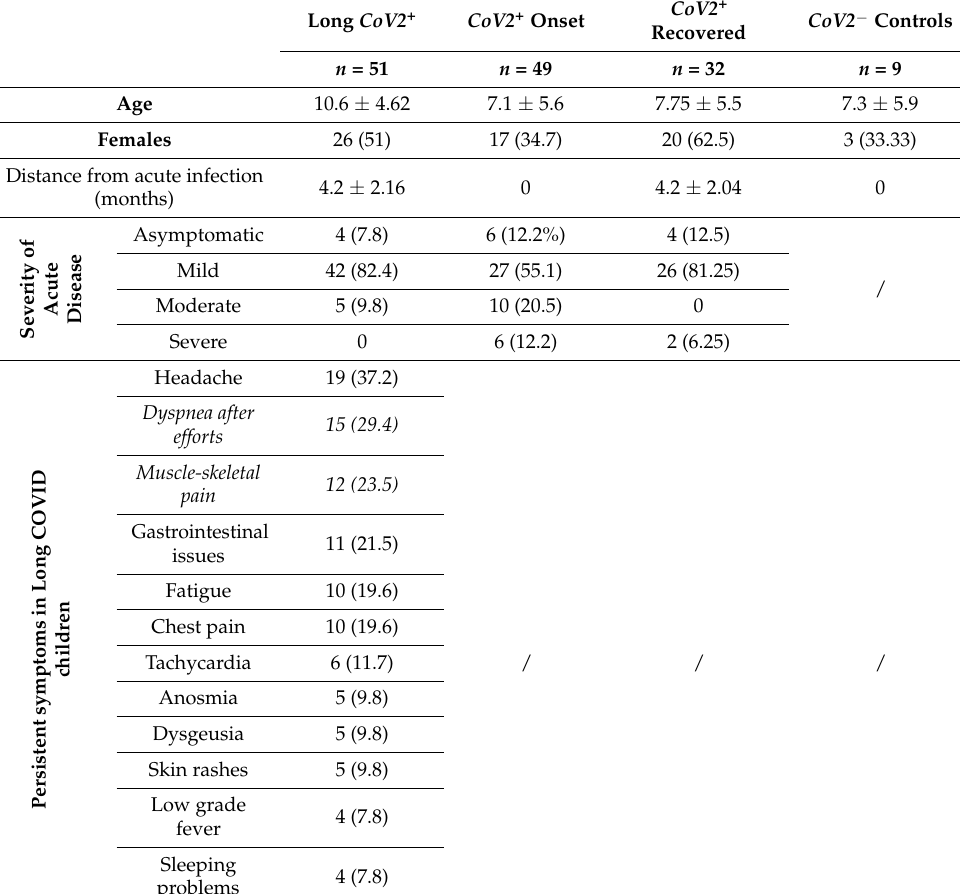
Table 1. Study population. Demographic, clinical and laboratory data of patients are divided into four groups: CoV2 + -infected children with persistent symptoms (Long CoV2 + ), at onset ( CoV2 + onset), after recovery of the symptoms ( CoV2 + recovered) and CoV2 − children. Infected children are subdivided into asymptomatic, with mild and with moderate/severe disease. Patients with severe disease are treated, according to our local protocols, with iv steroids and oxygen support. Patients with mild/moderate disease receive only supportive treatment (iv fluids and antipyretics/pain control). CoV2 + Long CoV2 + CoV2 + Onset